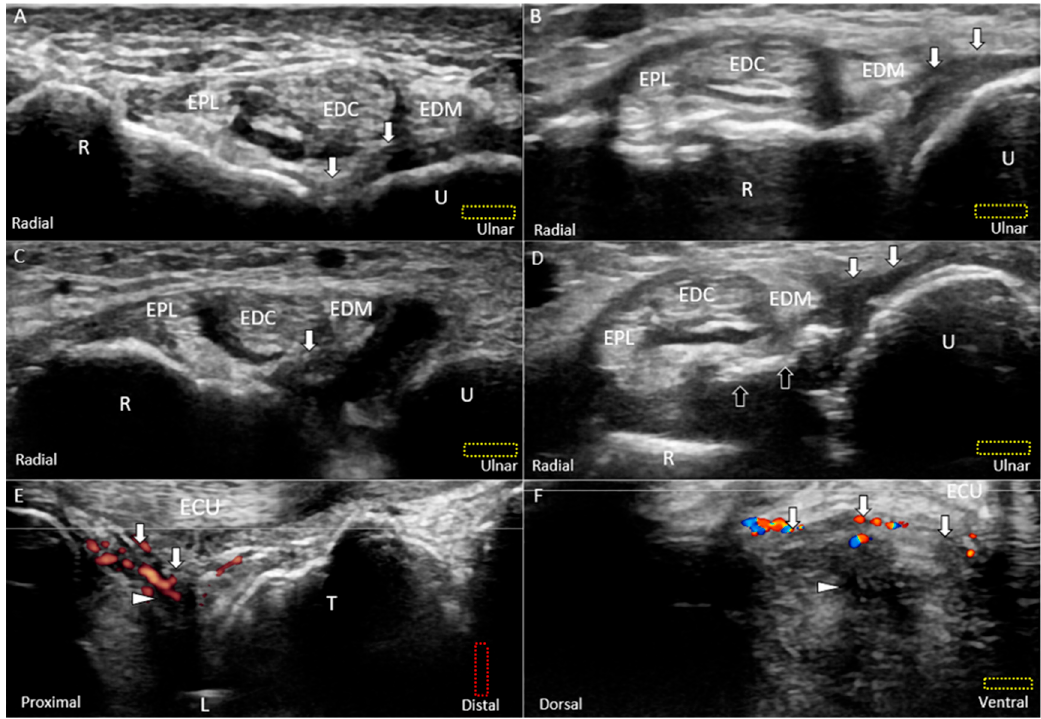
Figure 13. US images (short ‐ axis view) of the ( A ) normal, ( B ) partially torn, ( C ) completely torn, and ( D ) avulsed dorsal radioulnar ligaments (white arrow) . Doppler US imaging of the inflamed dorsal radioulnar ligaments and central tear of the articular disc (white arrowhead) using the ( E ) long ‐ axis and ( F ) short ‐ axis views. All lesions are categorized under Class 1E injuries. The different color dashed rectangles are in accordance with the transducer positions in Figure 3. US: ultrasound; black arrow: avulsed bony fragment from the radius; U: ulna; R: radius; L: lunate; T: triquetrum; EPL: extensor pollicis longus; EDC: extensor digitorum communis; EDM: extensor digiti minimi; ECU: extensor carpi ulnaris .